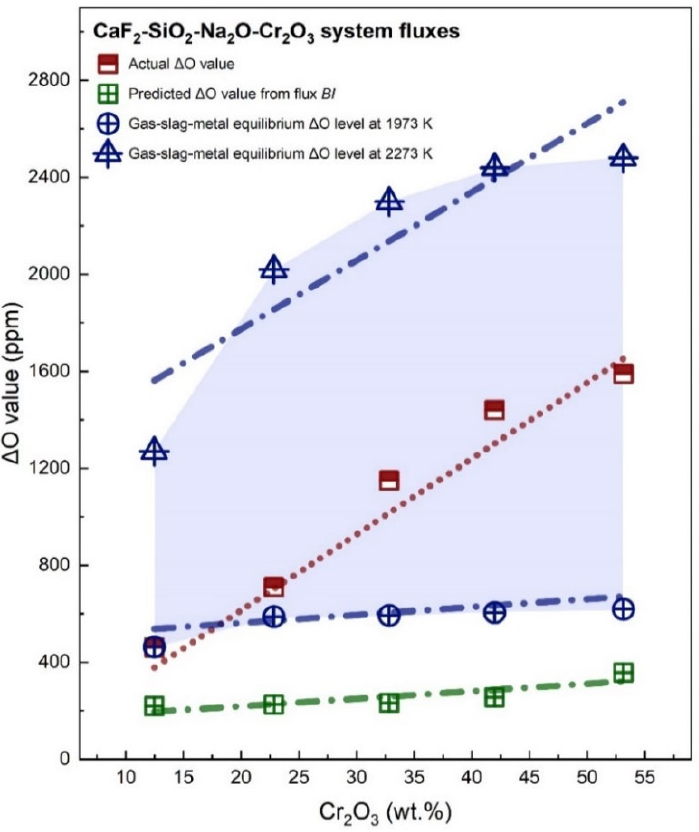
Figure 2. Actual and predicted Δ O levels as a function of the Cr 2 O 3 addition level in the flux.